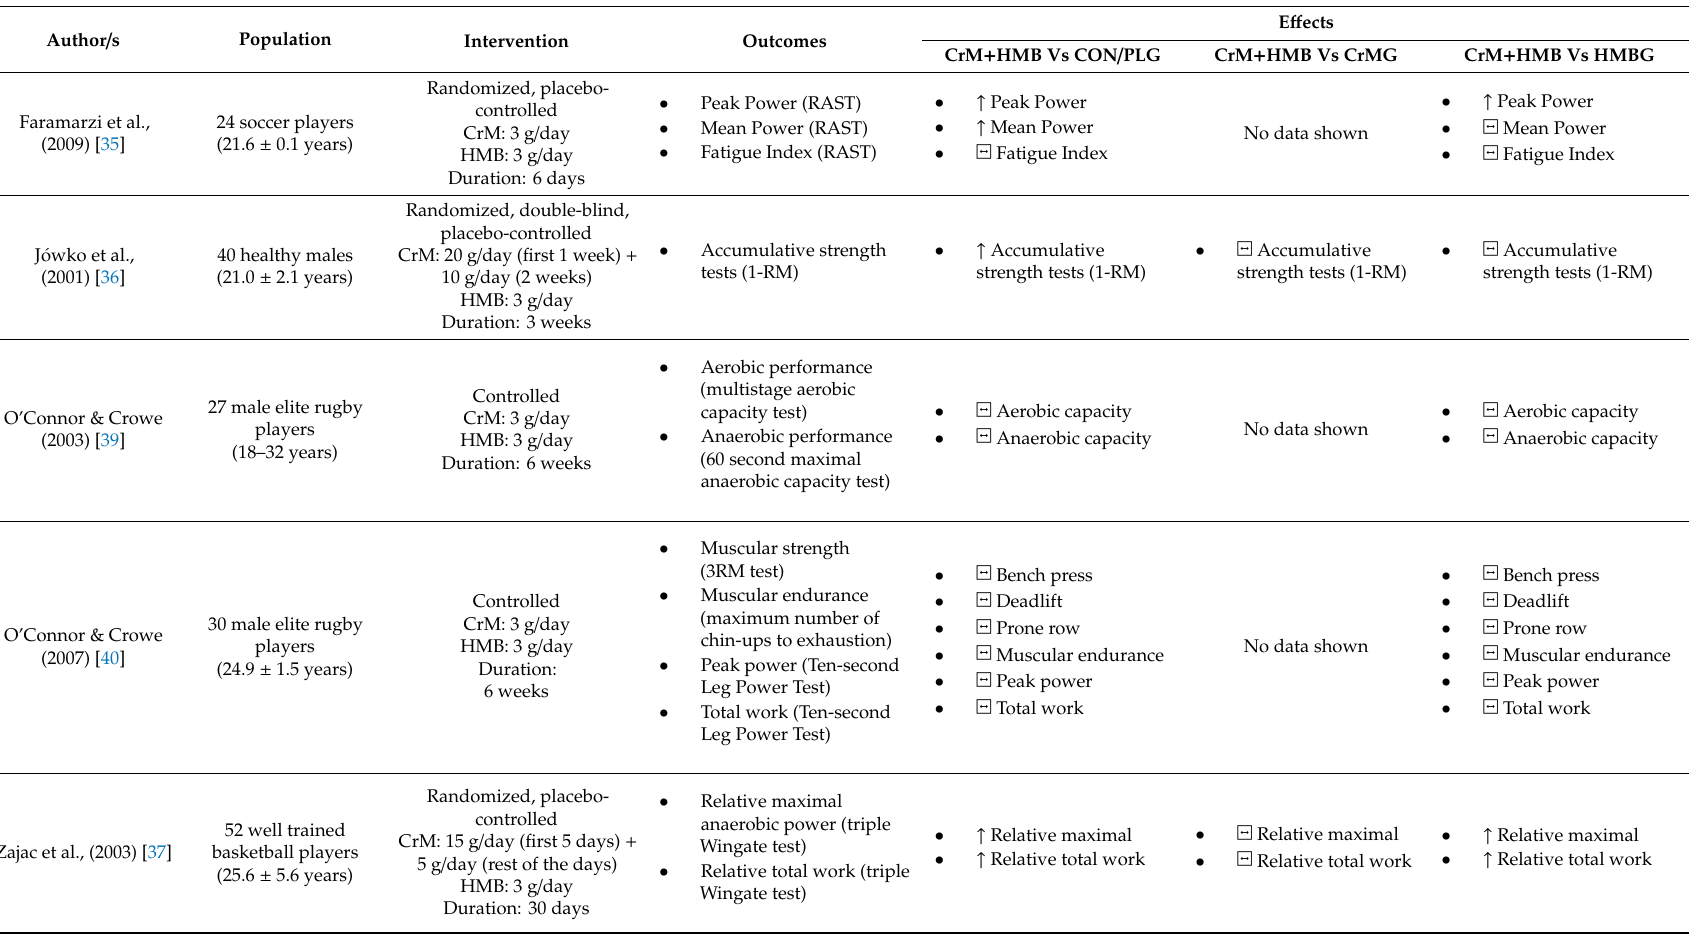
Table 1. Summary of studies included in the systematic review that investigated the e ff ect of CrM plus HMB on athletic performance